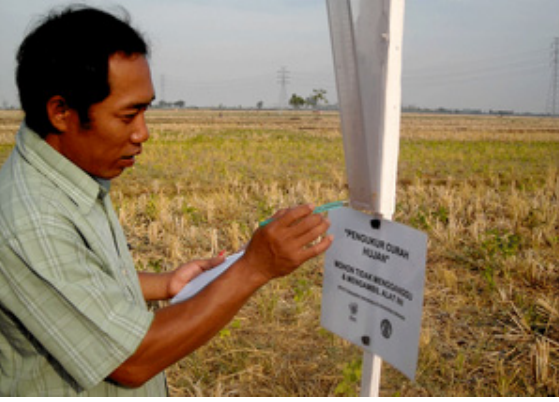
Figure 1. Unusual weather patterns helped farmers see the relationship between daily rainfall quantities (as measured by the farmer pictured), soil moisture and the growth of their crops in Indramayu, Indonesia. Photo by Yunita Winarto